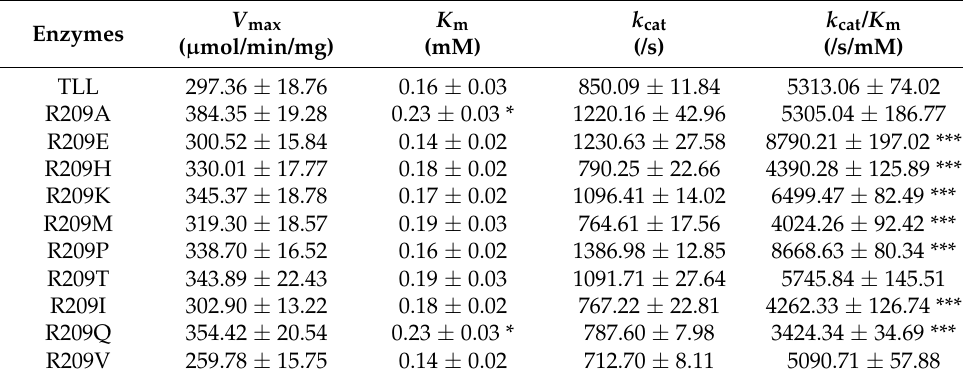
Table 2. Kinetics of TLL and the ten R209 mutants.